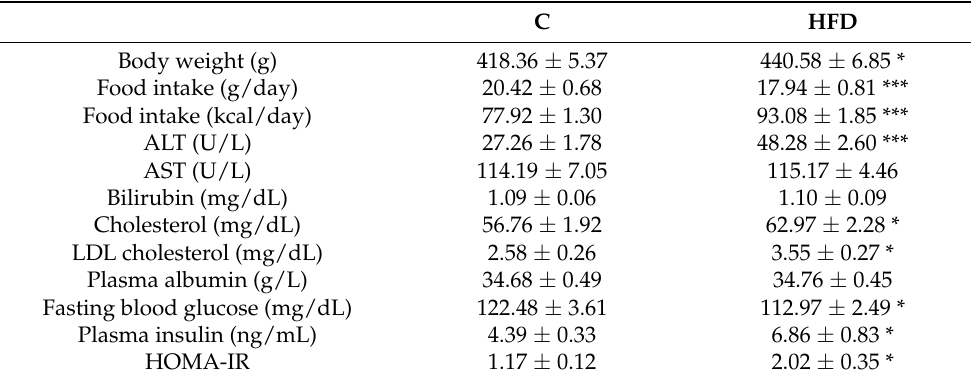
Table 1. Effect of six weeks of HFD feeding on parameters related to early obesity and NAFLD